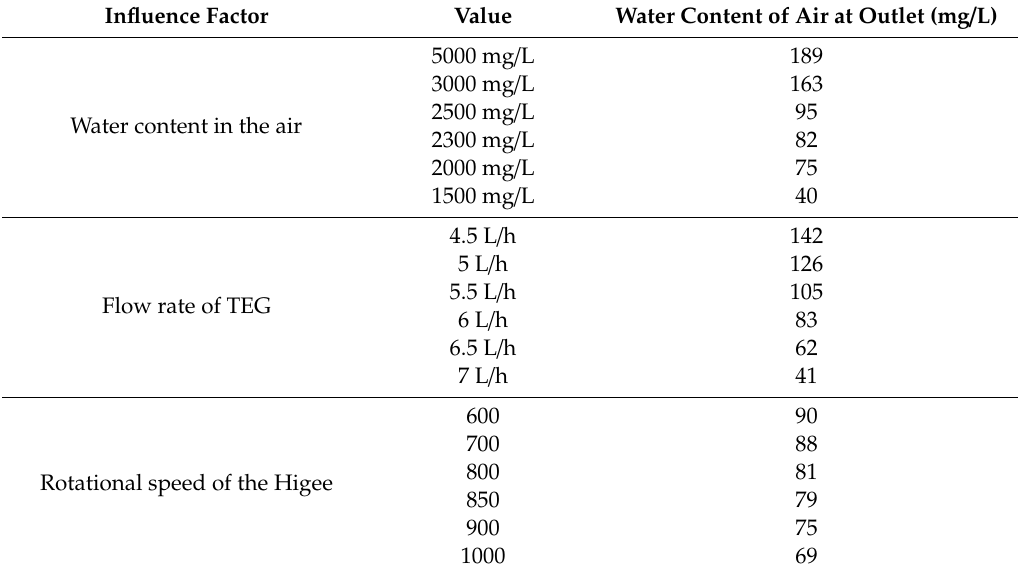
Table 5. Experimental results.